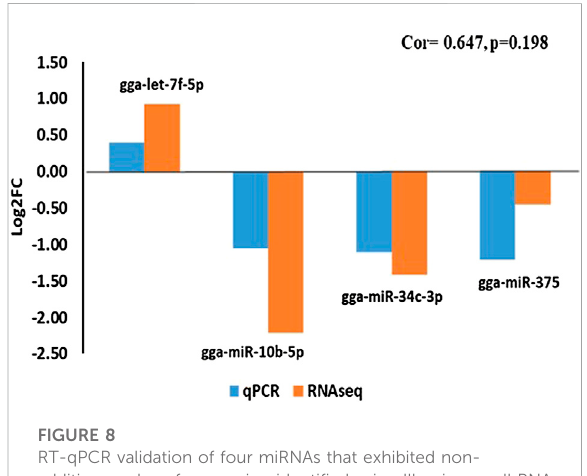
FIGURE 8 RT-qPCR validation of four miRNAs that exhibited non- additive modes of expression identi fi ed using Illumina small RNA deep